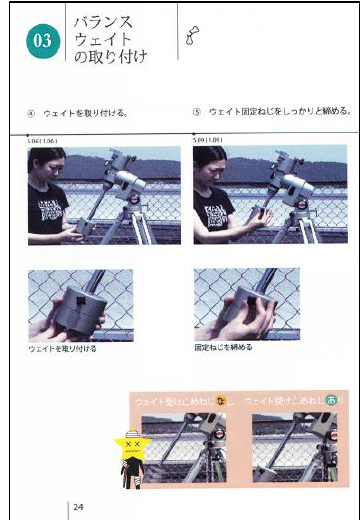
Figure 6. A page of the